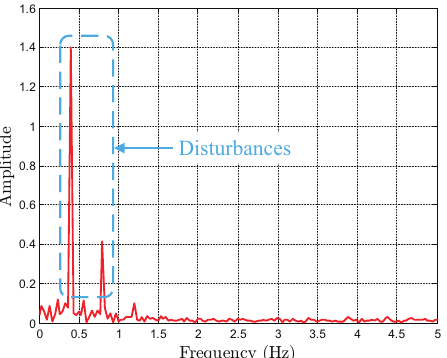
Figure 12. Amplitude spectrum of the feedforward compensation error r ( t ) − y ( t ) .